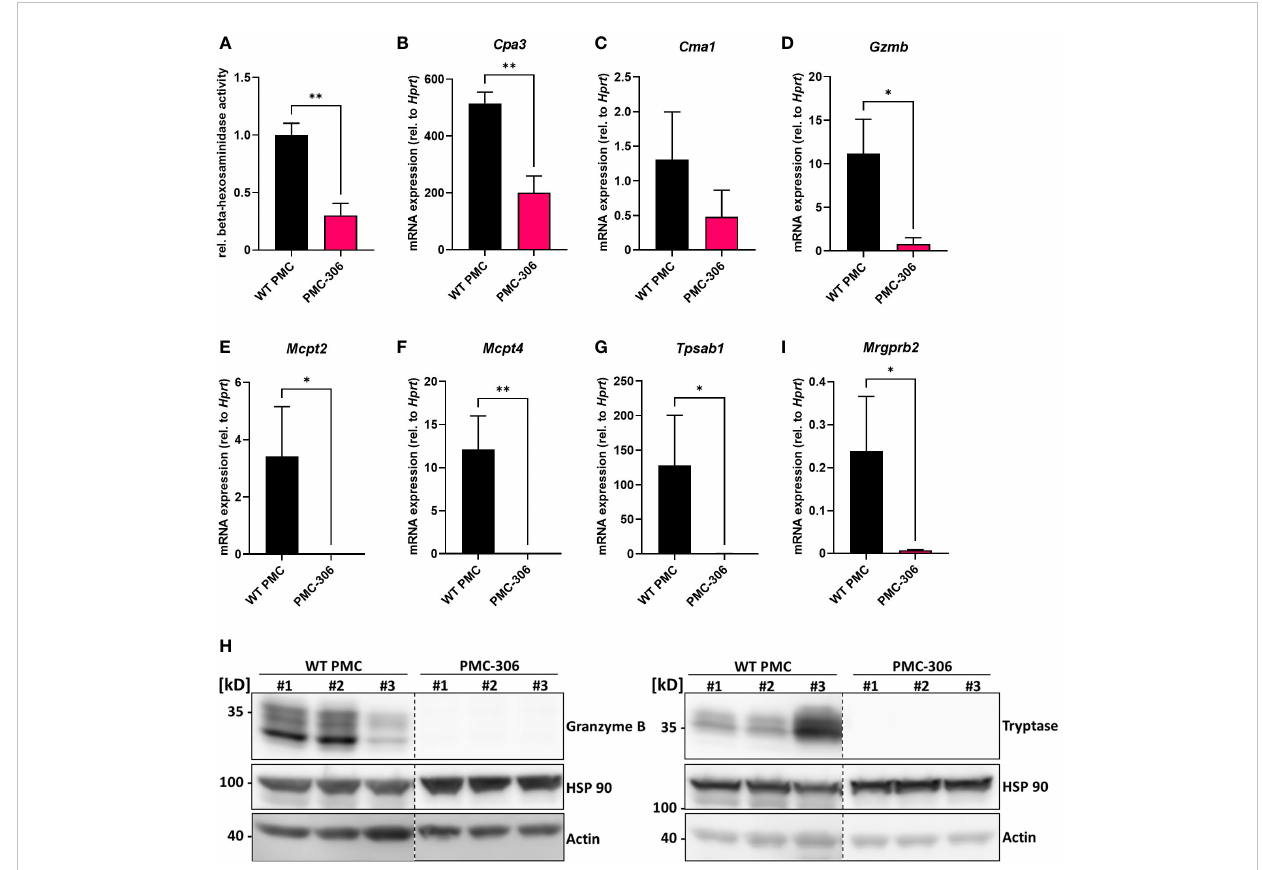
FIGURE 5 The repertoire of protease expression is reduced in PMC-306 cells revealing an immature MC phenotype. (A) The b -hexosaminidase content in primary PMCs and PMC-306 cells was determined by measuring the relative b -hexosaminidase activity in equal numbers of primary PMCs and PMC- 306 cells (n=3). (B – G) The protease expression of Cpa3 , Cma1 , Gzmb , Mcpt2 , Mcpt4 and Tpsab1 ( Mcpt7 ) and the expression of Mrgprb2 (H) were quanti fi ed by RT-qPCR in samples from fully differentiated primary PMCs and PMC-306 cells. Data are expressed as mRNA expression relative to Hprt determined according to the deltaC t method (n=3). (H) Representative Western blots of three lysates from three independent primary WT PMCs and independently taken samples from PMC-306 cells comparing the expression of granzyme B and tryptase on protein level. HSP 90 and actin served as loading controls. Data are shown as mean +SD. Unpaired, two-tailed Student ’ s t -test with Welsh ’ s correction. * p <0.05, ** p